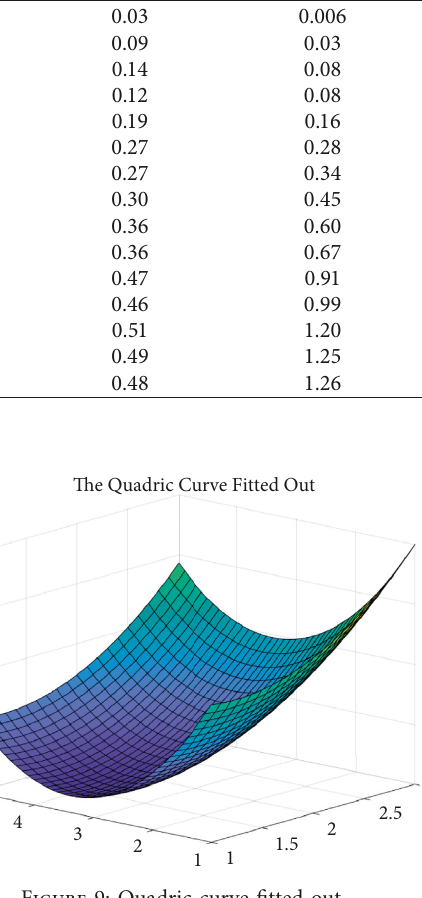
Figure 9: Quadric curve fitted